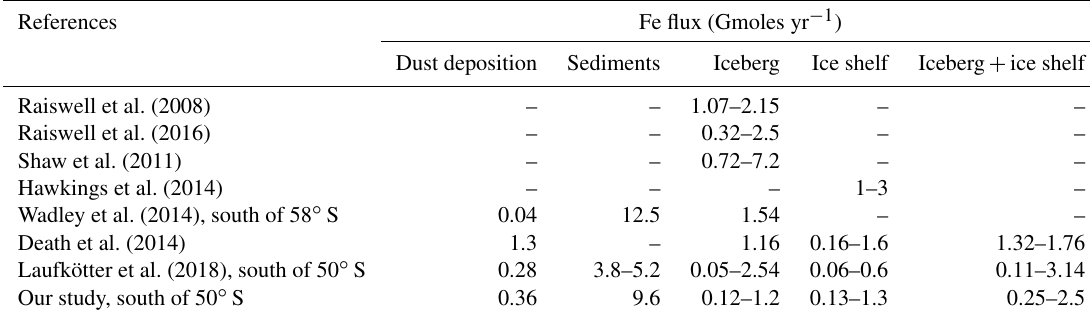
Table 1. Annual estimates of Fe fluxes from observational and modeling studies in the SO. The iceberg Fe flux from Raiswell et al. (2016) is calculated by applying an Fe solubility of 10% to their estimates of potentially bioavailable Fe fluxes.